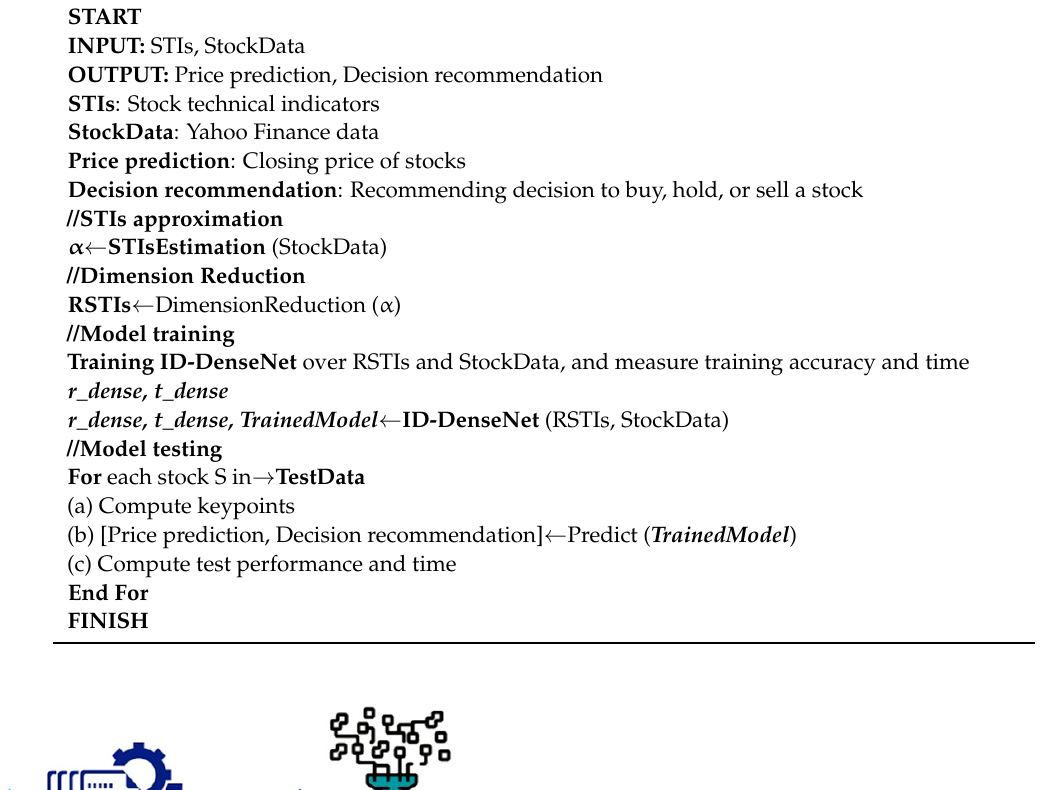
Algorithm 1: Steps for Stock Market Prediction.